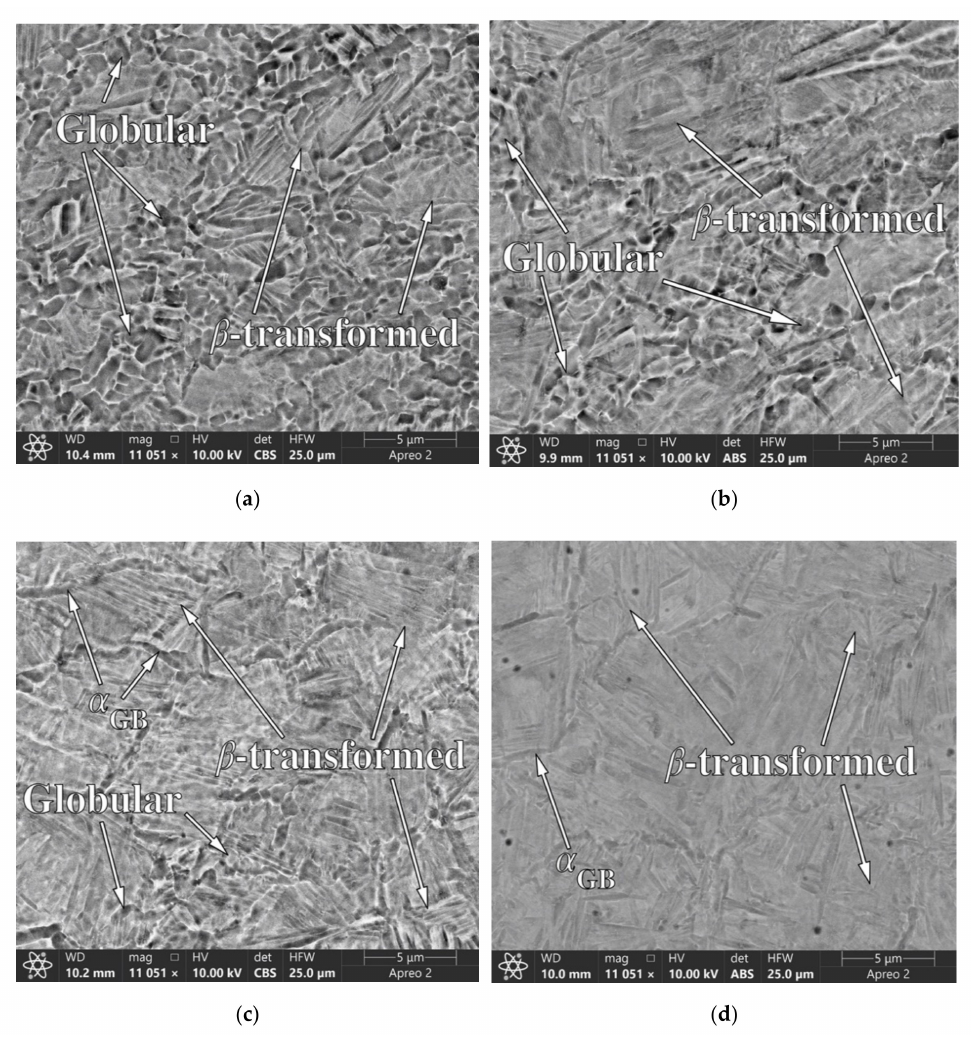
Figure 5. Stir zone microstructure of samples 1 ( a ), 2 ( b ), 3 ( c ) and 4 ( d ) captured in backscattered electron